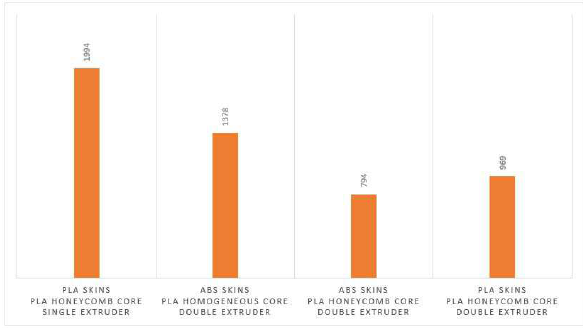
Figure 10: Stress-strain curve for specimen 6.